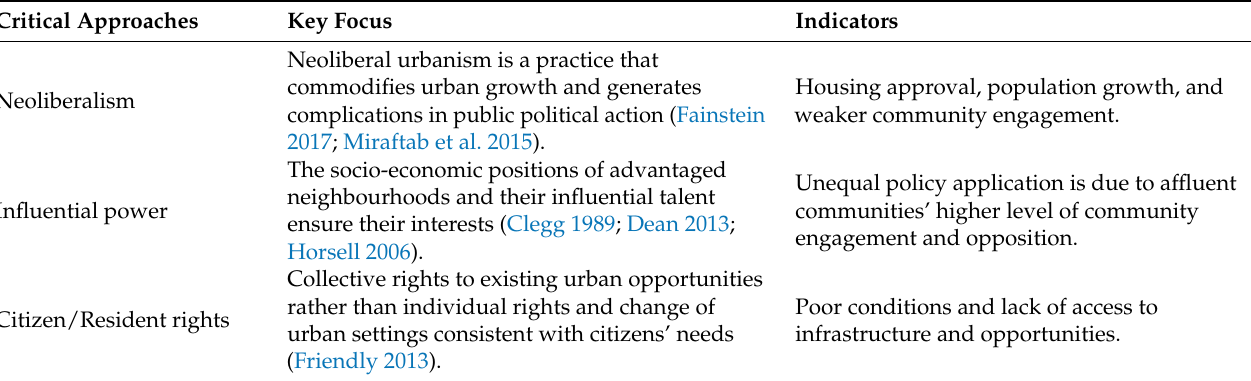
Table 2. Key focus and indicators of critical